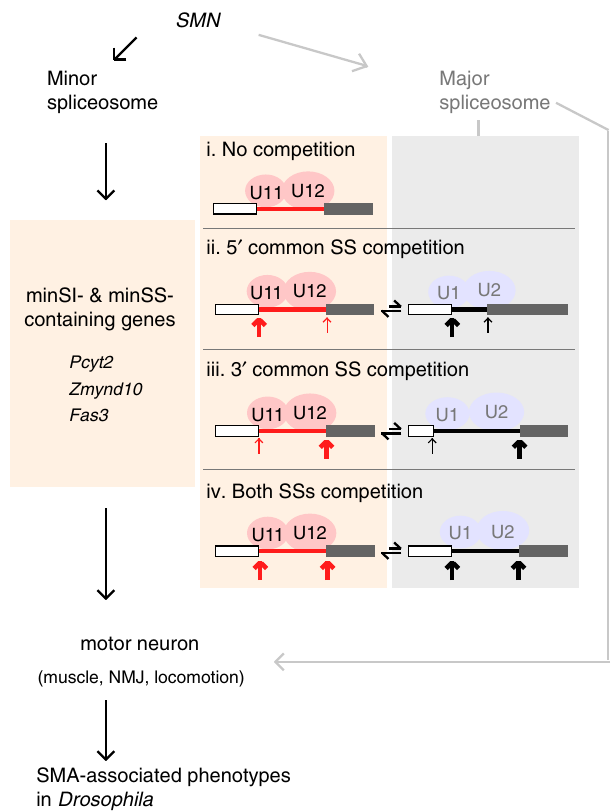
Fig. 7 Schematic of defective minor spliceosome induced SMA- associated phenotypes and competition model of minor intron recognition. SMN is the upstream gene of SMA; a defective minor spliceosome results in inhibited splicing of minS-I- and minS-SS-containing neural genes, and directly induces SMA-associated phenotypes. Splicing recognition of U12-type or minor sensitive introns (minS-I) are proposed as: (i) only by the minor spliceosome; (ii & iii) 5 ′ SS or 3 ′ SS is competitively recognized by the minor and major spliceosomes; (iv) both SSs are competitively recognized by the two